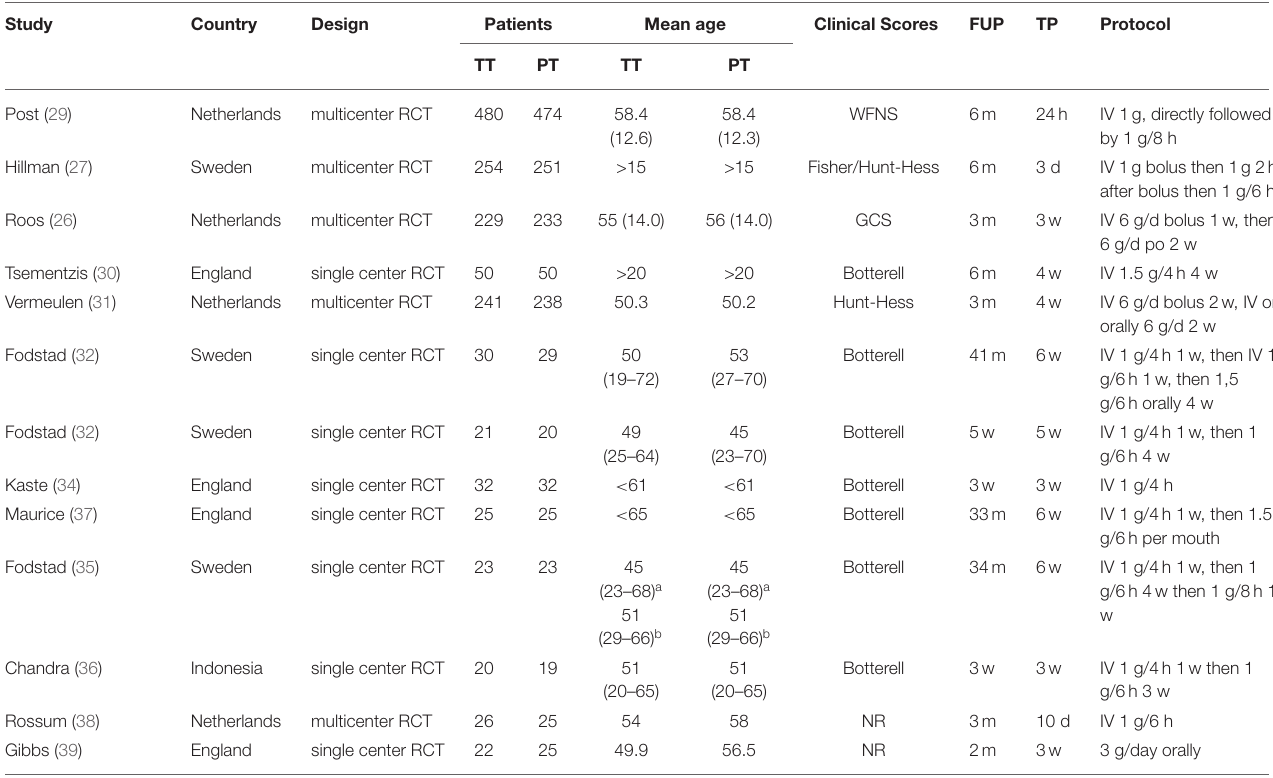
TABLE 1 | Baseline characteristics of the included studies.